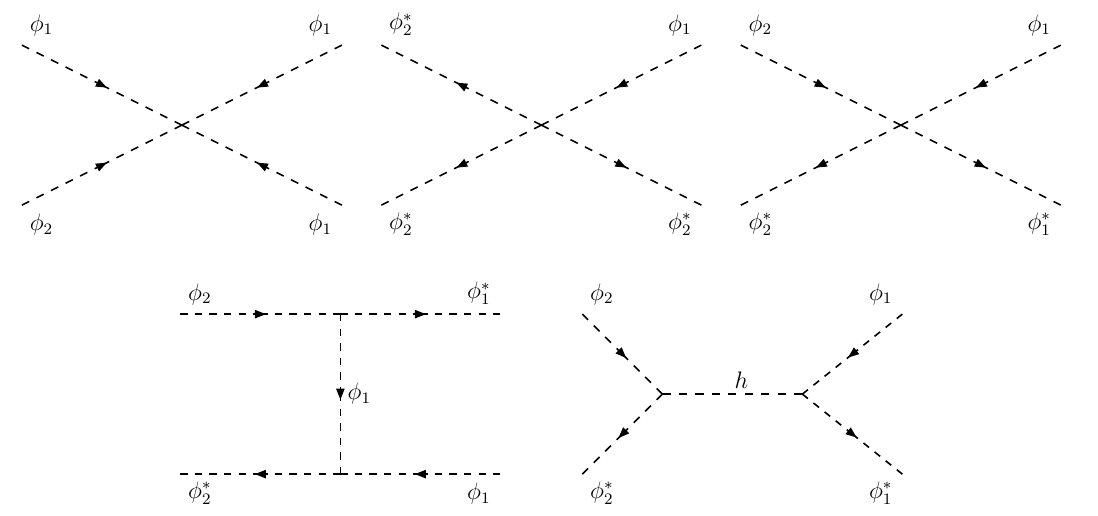
Figure 2 . Dark matter conversion processes. Top: via quartic interactions | (cid:21) 31 (left), (cid:21) 32 (center) and (cid:21) 412 (right). Bottom: via a (cid:22) S 1 trilinear interaction (left) or Higgs-portal couplings